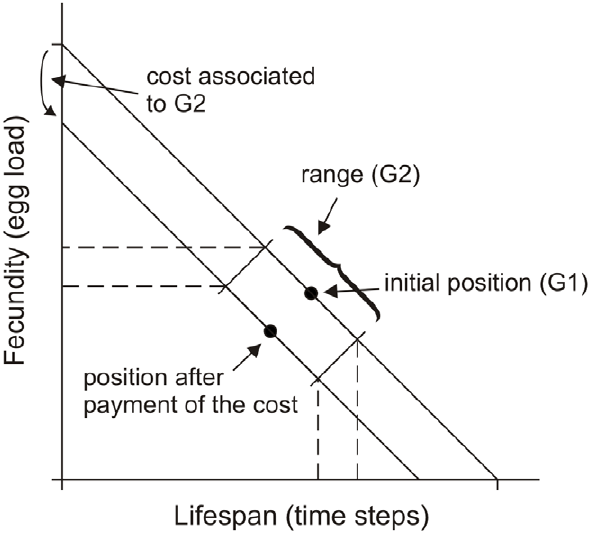
Figure 1. Trade-off between lifespan and egg load describing the main parameters used in the simulation model. The initial reproductive strategy is defined by G1 and each animal has a certain phenotypic plasticity defined by the range G2, but pays a linearly proportional cost for it, both in survival time and egg load. A third parameter G3 (not shown) defines a learning ability used by the animal to move along such a phenotypic plasticity. Optimal values of the parameters G1, G2 and G3 in different habitats are estimated by means of a genetic algorithm (see text).